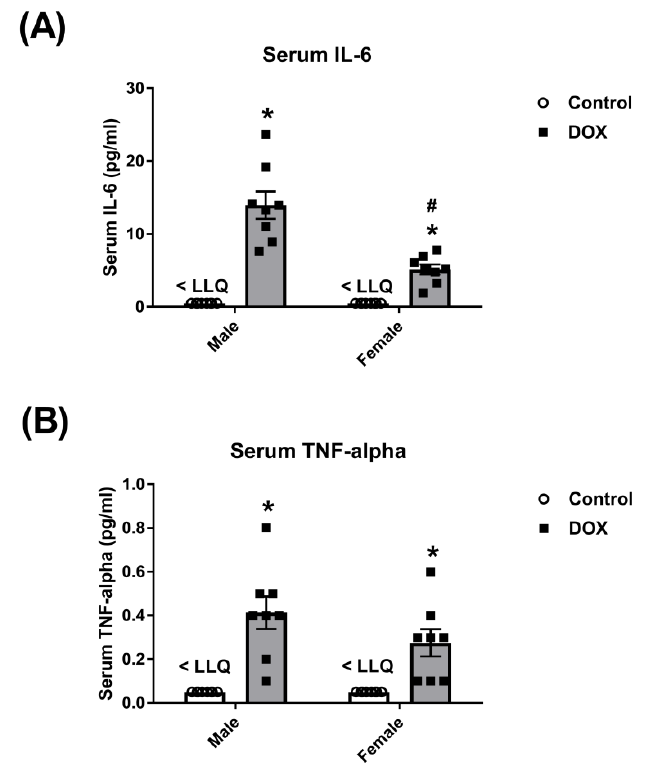
Figure 1. E ff ect of DOX treatment on the serum level of inflammatory markers. Serum was collected from male or female C57Bl / 6 mice 24 h following the administration of a single intraperitoneal injection of 20 mg / kg DOX or saline ( n = 8 per group). Inflammatory markers ( A ) IL-6 and ( B ) TNF-alpha were measured using the Luminex platform. Data are presented as the mean ± SEM. * p < 0.05, compared to saline-treated mice of the same sex; # p < 0.05, compared to male DOX-treated mice.